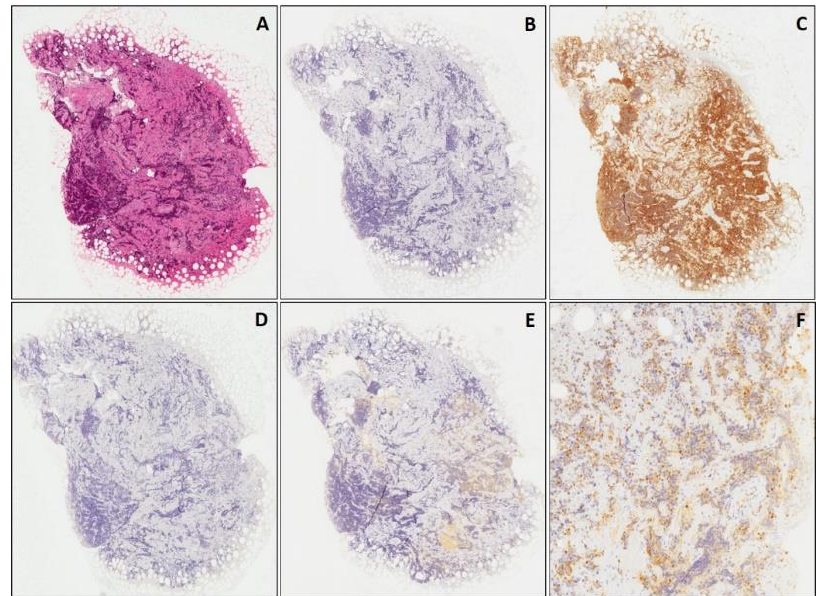
Figure 6. Subcutaneous nodule in a patient with a previous diagnosis of neuroblastoma. ( A ) Low magnification of a subcutaneous nodule of NB: section stained with hematoxylin & eosin. Neo- plastic cells were negative for NB84 ( B ) and WT1 ( D ); diffuse staining was obtained with CD56 ( C ) and cyclin D1, at low ( E ) and higher ( F ) magnification. ( A – E : original magnification 40×; F : original magnification 100×).